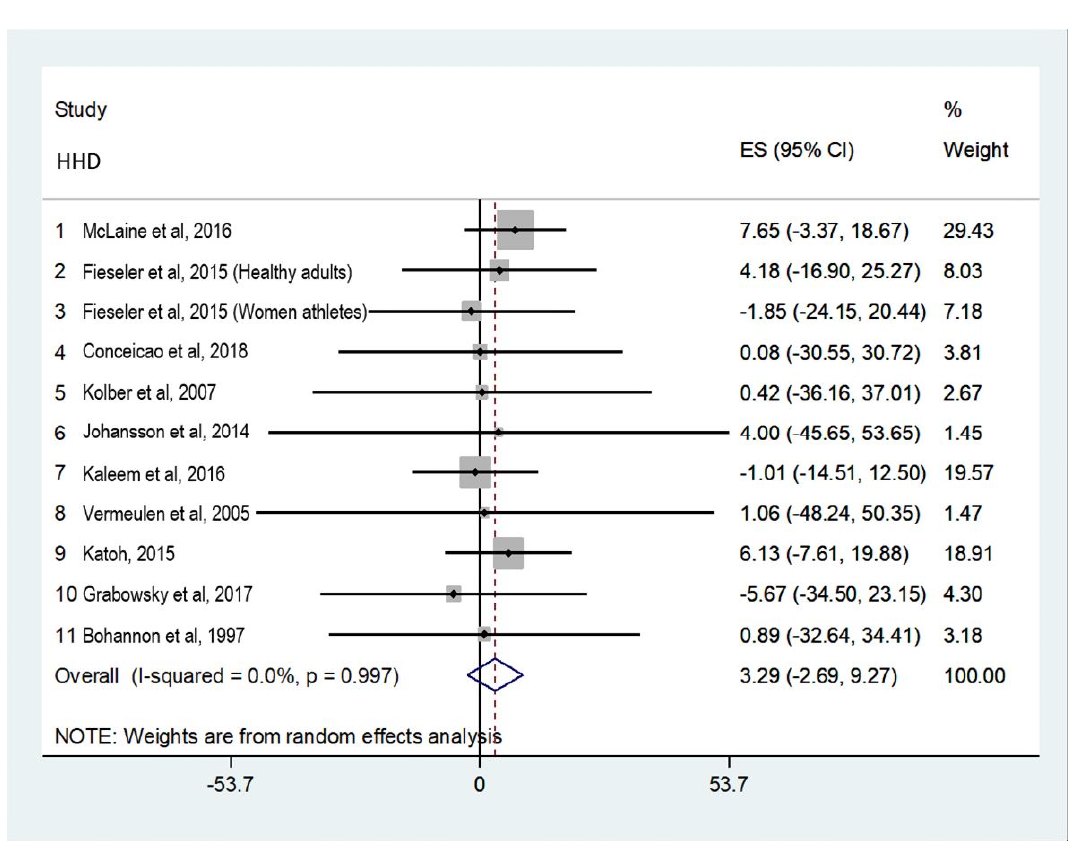
Figure 2. Absolute reliability for shoulder internal rotator strength assessment.